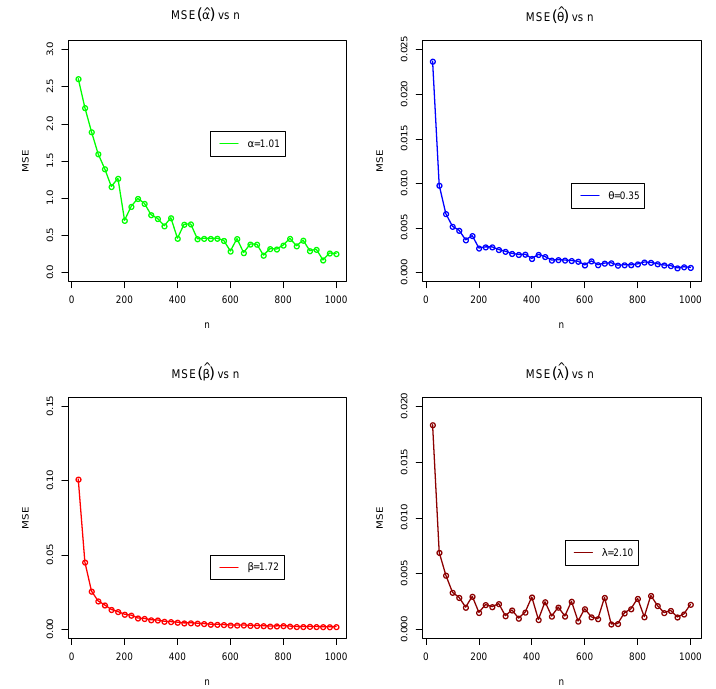
Figure 6. For set 2, α = 1.01, θ = 0.35, β = 1.72, λ = 2.10, MSE plots of the GAEPPRD.